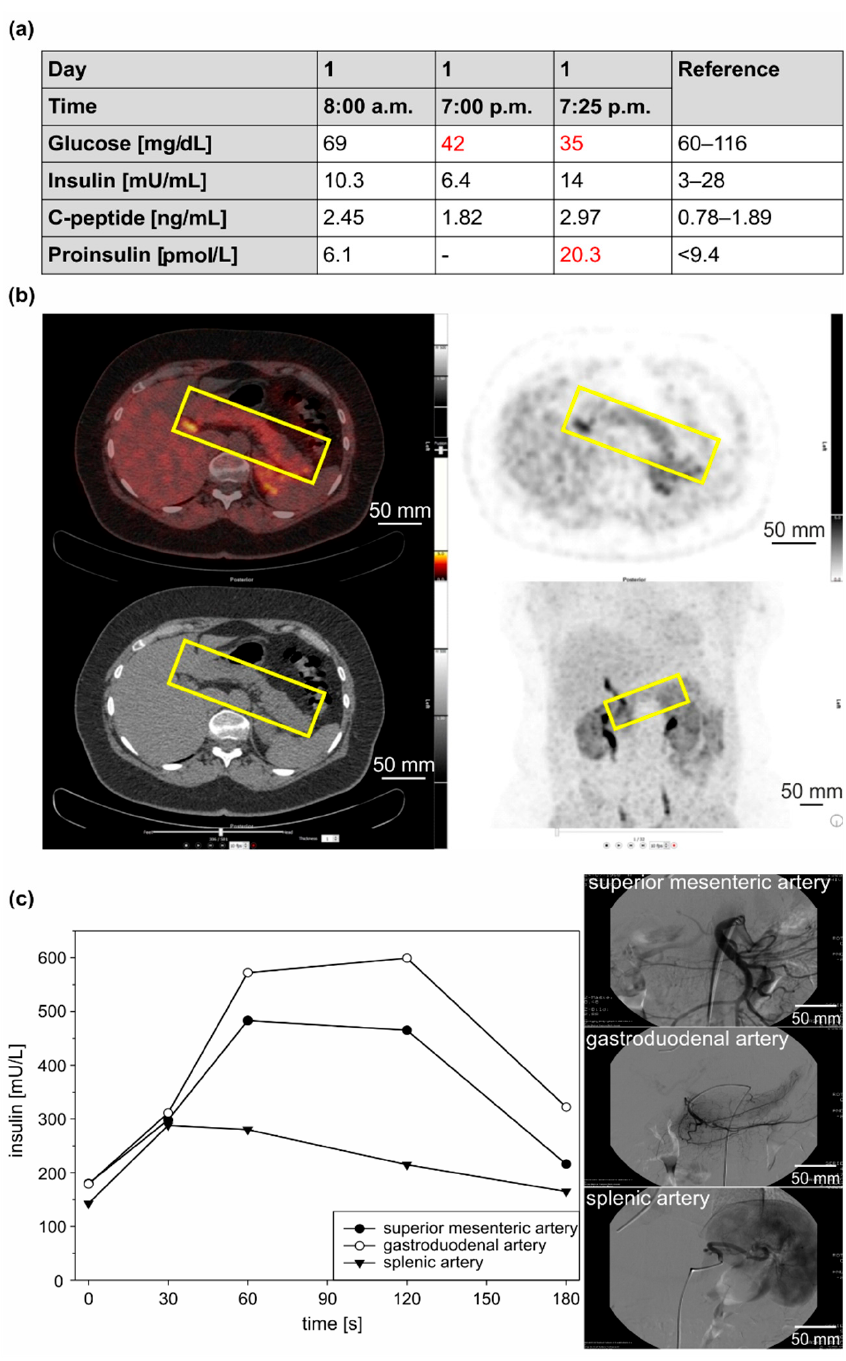
Figure 4. Laboratory tests and diagnostic imaging of case 2 (sister of index patient, IV3). Endocrine testing showed normal prolonged oral glucose tolerance without clinical or biochemical signs of hypoglycemia (data not shown). ( a ) A 72 h fasting test was stopped after 11 h showing inadequately elevated insulin, C-peptide, and proinsulin levels. (- = not performed). Values outside the reference range are highlighted in red. ( b ) Functional imaging with 18F-DOPA-PET/CT showed physiological radionuclide-accumulation in the common bile duct and a diffuse, non-homogeneous uptake in the whole pancreas (yellow frame), judged to be unspecific. ( c ) The selective arterial calcium infusion (SACI)-test showed a 2- to 3-fold increase of insulin secretion after calcium-stimulation of all three arteries (superior mesenteric, gastroduodenal and splenic